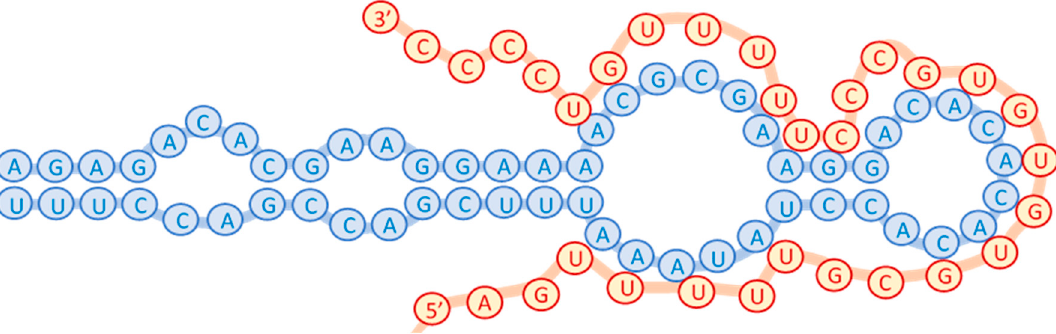
Figure 1. Binding of the CG-3 RNA-aptamer (red balls and line) to a subsection of PCA3 consisting of 277 bases from the lncRNA transcript (blue balls and line). Image reproduced from [46].